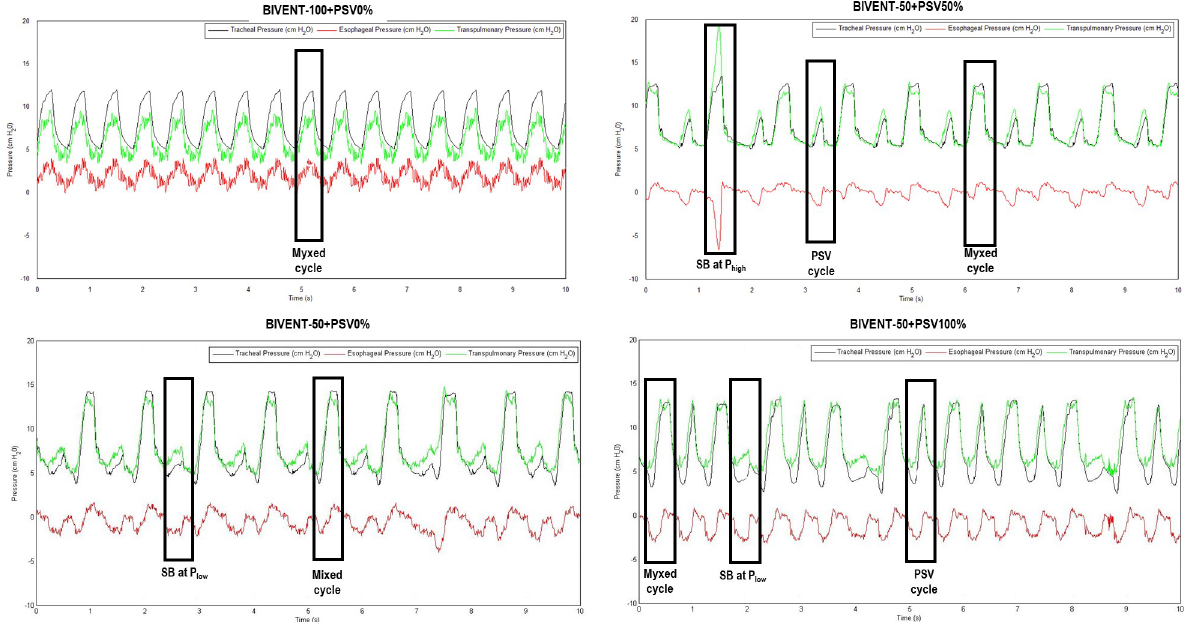
Fig 2. Original tracheal, esophageal and transpulmonary pressure